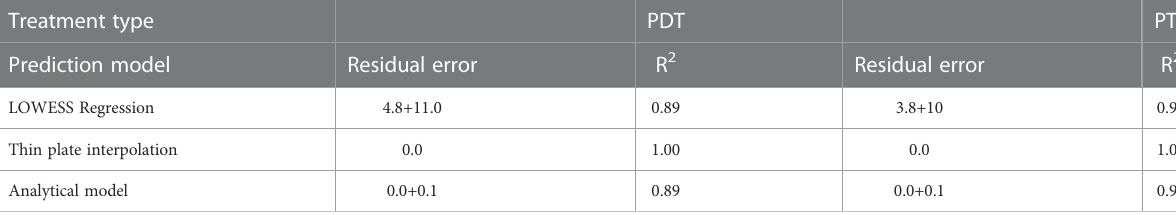
TABLE 1 Training error analysis results, goodness of fi